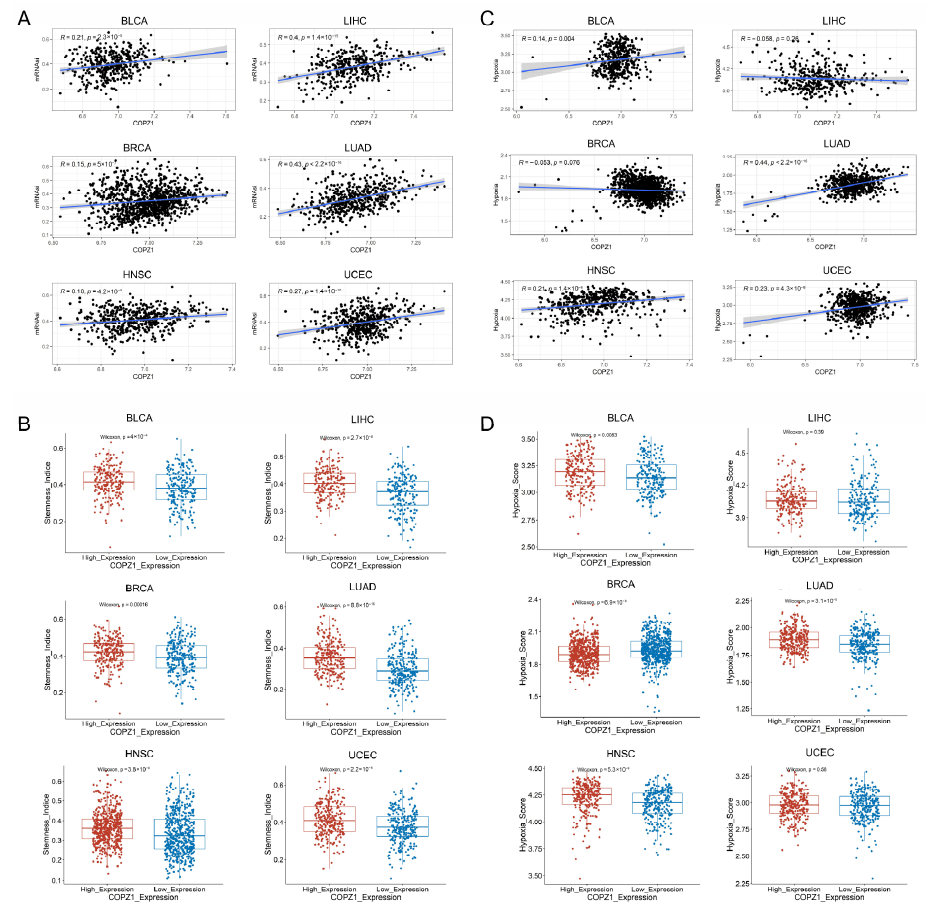
Figure 4. Correlation analysis between COPZ1 expression and stemness score and hypoxia score. ( A ) Correlation between COPZ1 expression and the stemness score. ( B ) The stemness index between high and low COPZ1 expression groups. ( C ) Correlation between COPZ1 expression and the hypoxia score. ( D ) The hypoxia score between high and low COPZ1 expression groups. The red box means high COPZ1 expression group, and the blue box means low COPZ1 expression group.